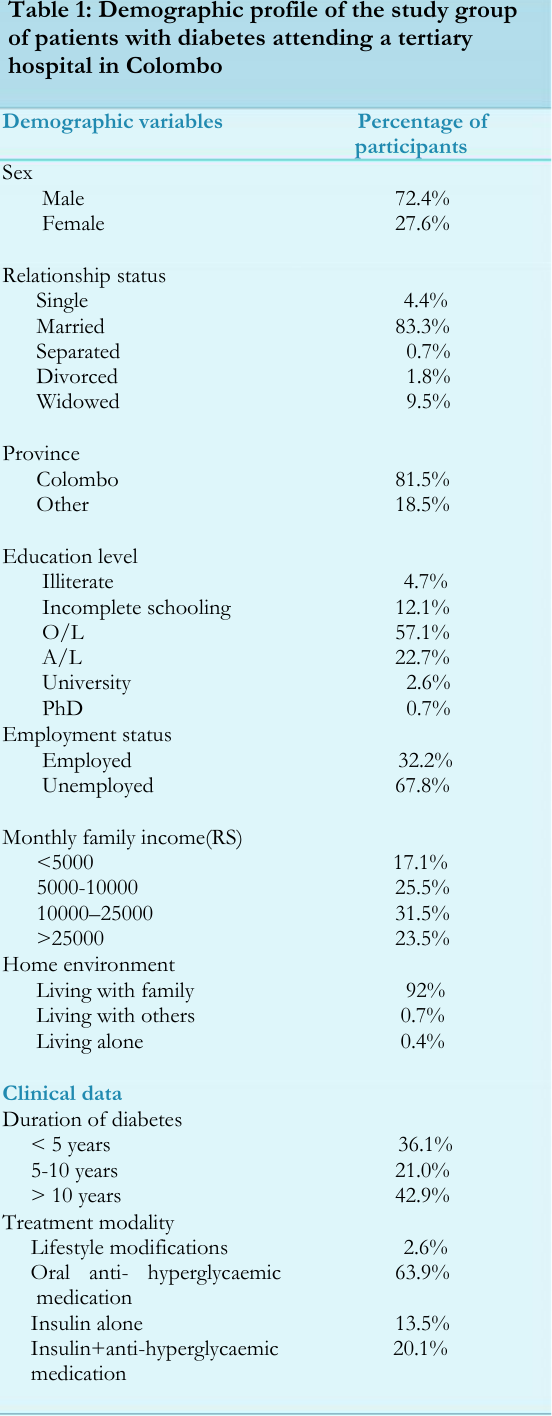
Table 1: Demographic profile of the study group of patients with diabetes attending a